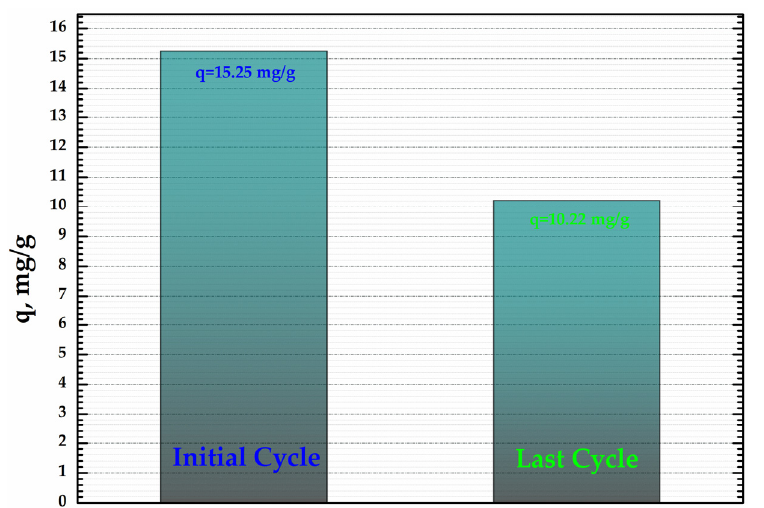
Figure 10. Direct comparison of adsorption capacity (q, mg/g) related to the initial cycle vs. the last cycle.